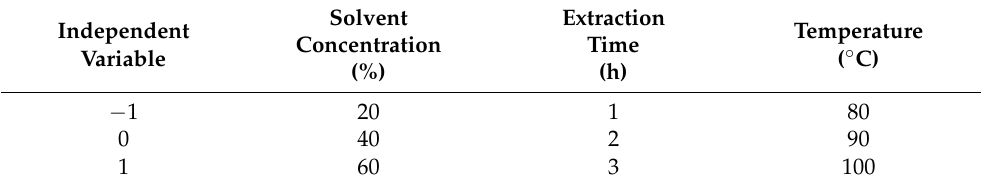
Table 1. Factor levels and design matrix in the Box–Behnken central composite design model. Independent